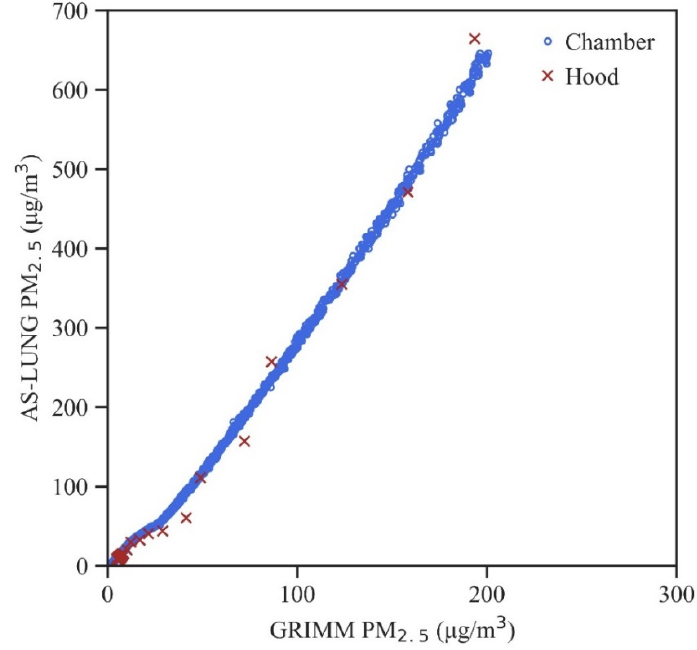
Figure 3. An example of the raw PM 2.5 data obtained in the hood and chamber experiments with